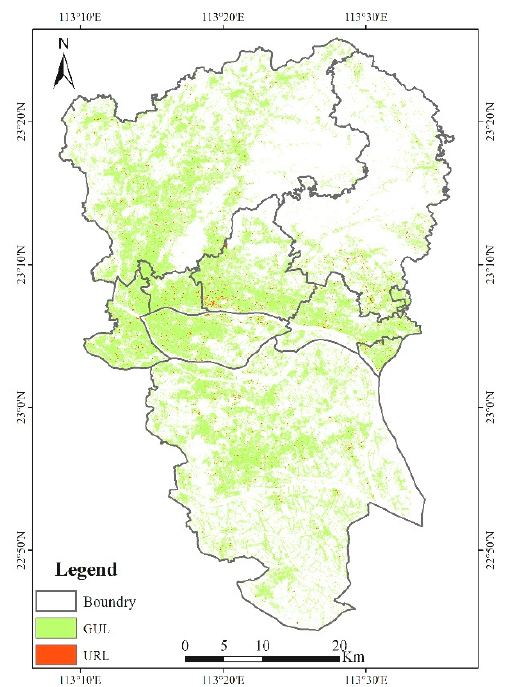
Figure 7. Spatial distribution of urban renewal land (URL) and general urban land (GUL) in the study area.